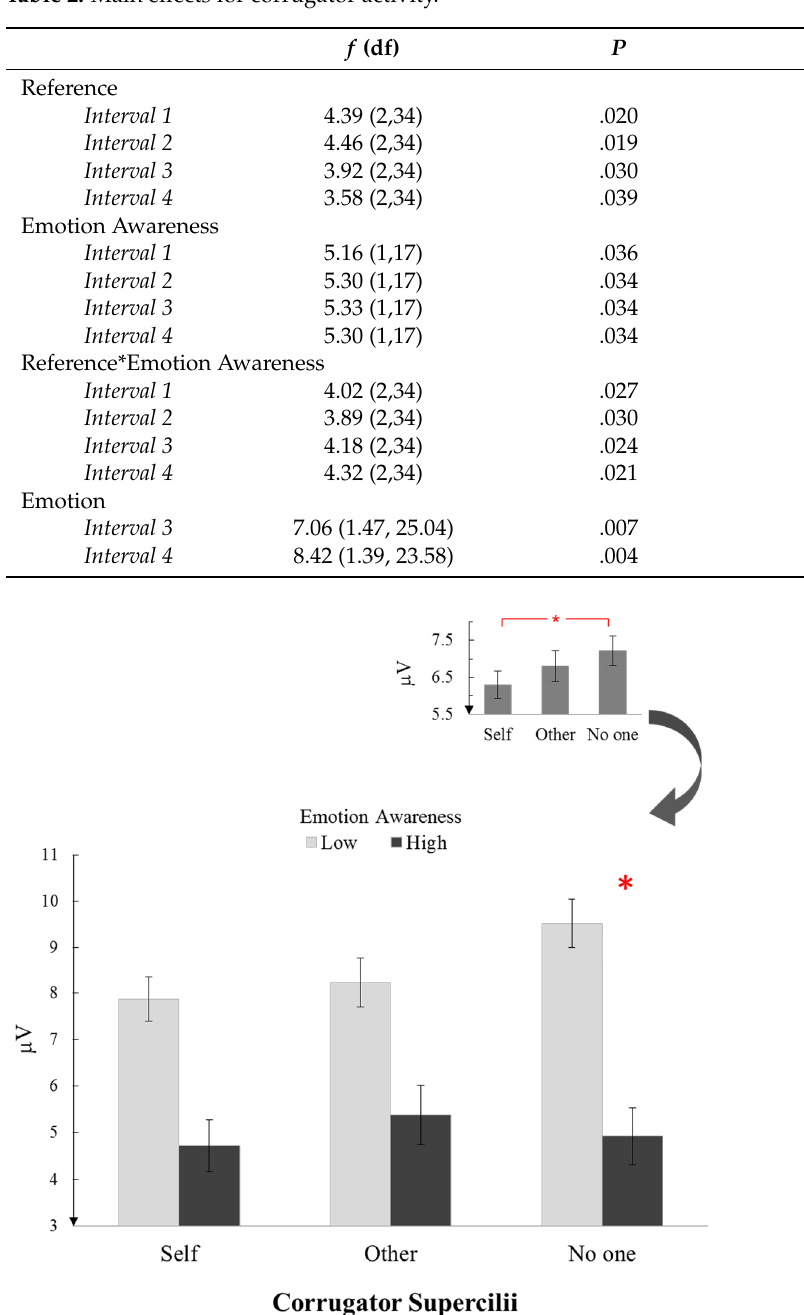
Table 2. Main effects for corrugator activity.